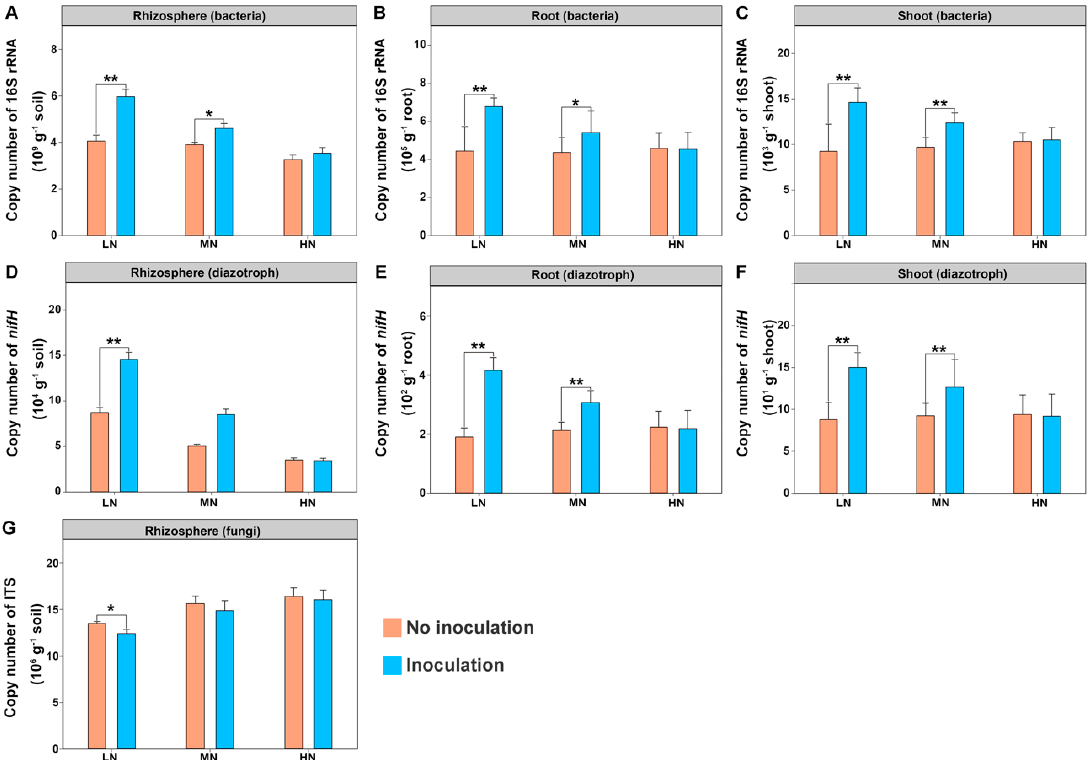
Figure 2. Copy numbers of the 16S rRNA gene (bacteria), nifH gene (diazotrophs) and ITS (fungi) in the maize rhizosphere, root and shoot: ( A ) the rhizosphere bacteria; ( B ) the root endophytic bacteria; ( C ) the shoot endophytic bacteria; ( D ) the rhizosphere diazotrophs; ( E ) the root endophytic diazotrophs; ( F ) the shoot endophytic diazotrophs; ( G ) the rhizosphere fungi. The values are given as the means of three independent biological replicates. The asterisk(s) (* or **) indicate significant differences between the inoculated and uninoculated groups determined by Student’s t at p < 0.05 or p < 0.01. LN: low nitrogen; MN: medium nitrogen; HN: high nitrogen.